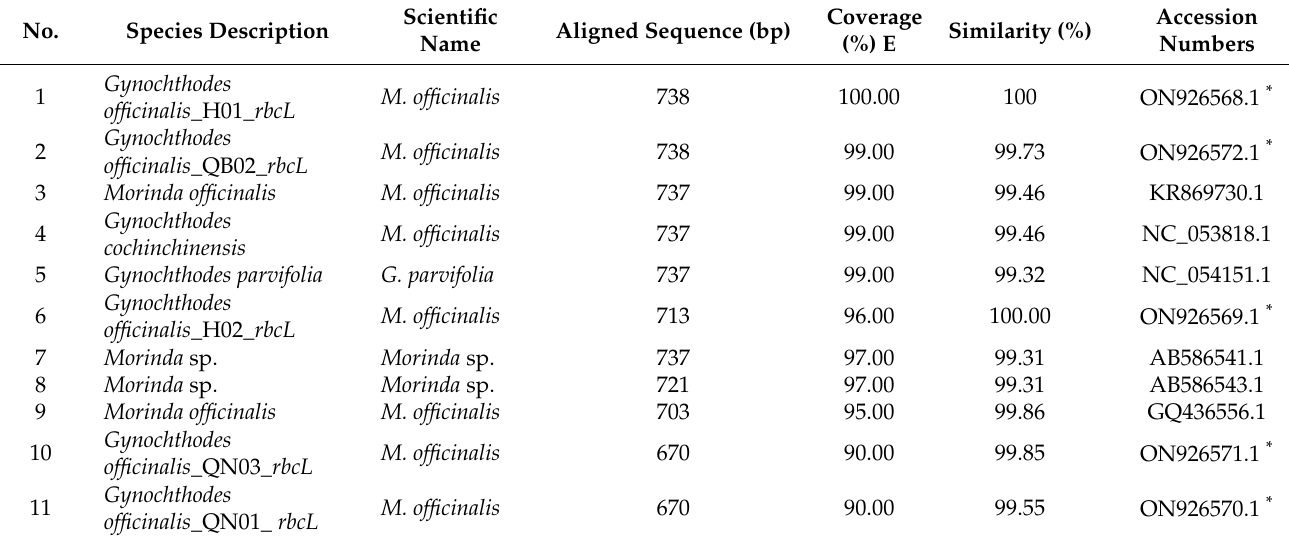
Table 6. M. officinalis plants in this study and percentage of similarity with the closest species in the GenBank base as per rbcL gene sequences.